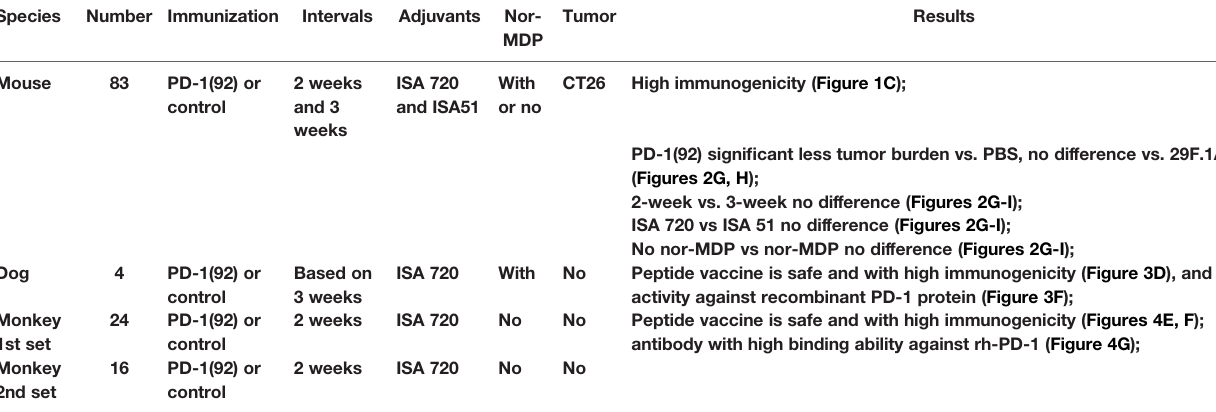
TABLE 2 | Summary of mouse, dog, and non-human primate